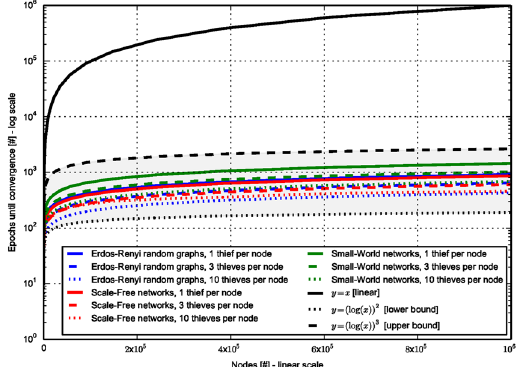
Figure 3. GOT scalability. The plot shows the number of epochs needed by GOT to converge. For each network used, the number of edges is between 5 and 10 times bigger than the number of nodes. Independently of the network model, or the number of agents used per node (i.e. 1, 3, or 10), GOT convergences in a number of epochs empirically lower-bounded by log 2 | V | and upper-bounded by log 3 | V |, which is on the polylogarithmic scale with respect to the total number of nodes in the network, | V |.